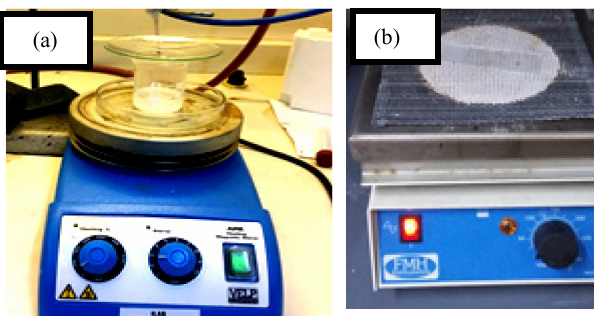
Fig. 2. The images showing (a) the heating processes used during the production of C 2 D 4 targets by dissolving the powdered deuterated polyethylene in xylene and (b) the polymerization of C 2 D 4 on a heated glass slide